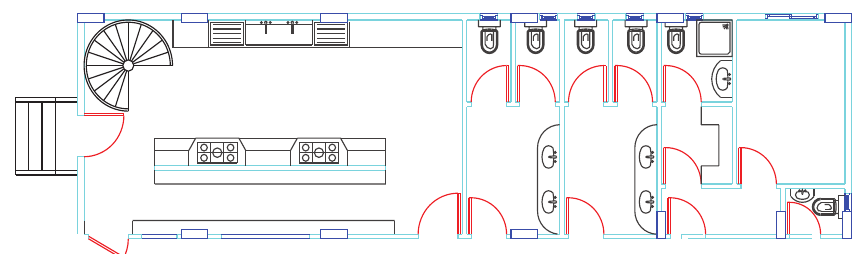
Figure 6: Example of a fl oor plan designed using a CAD